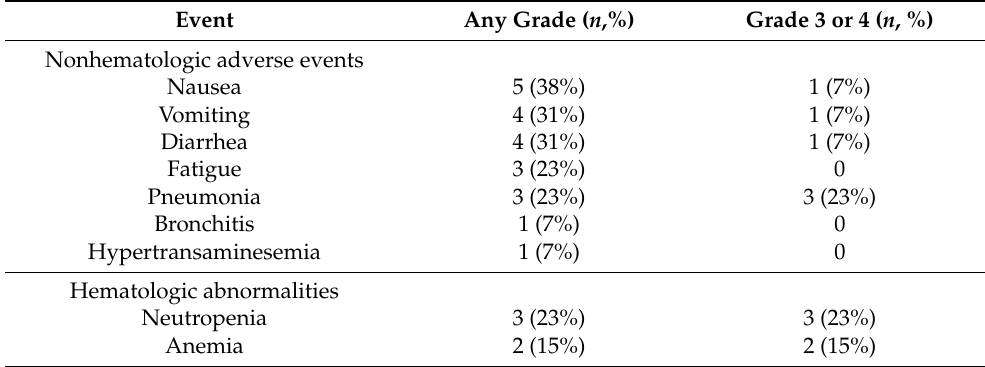
Table 3. Adverse events in the